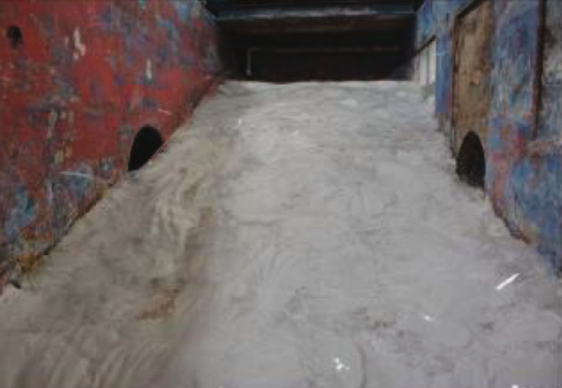
Figure 9: The paving of sliding belt materials.